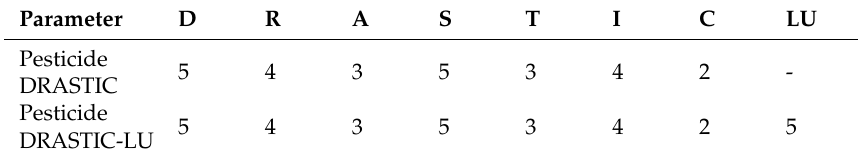
Table 5. Weights assigned to the parameters in Pesticide DRASTIC, Pesticide DRASTIC-LU.